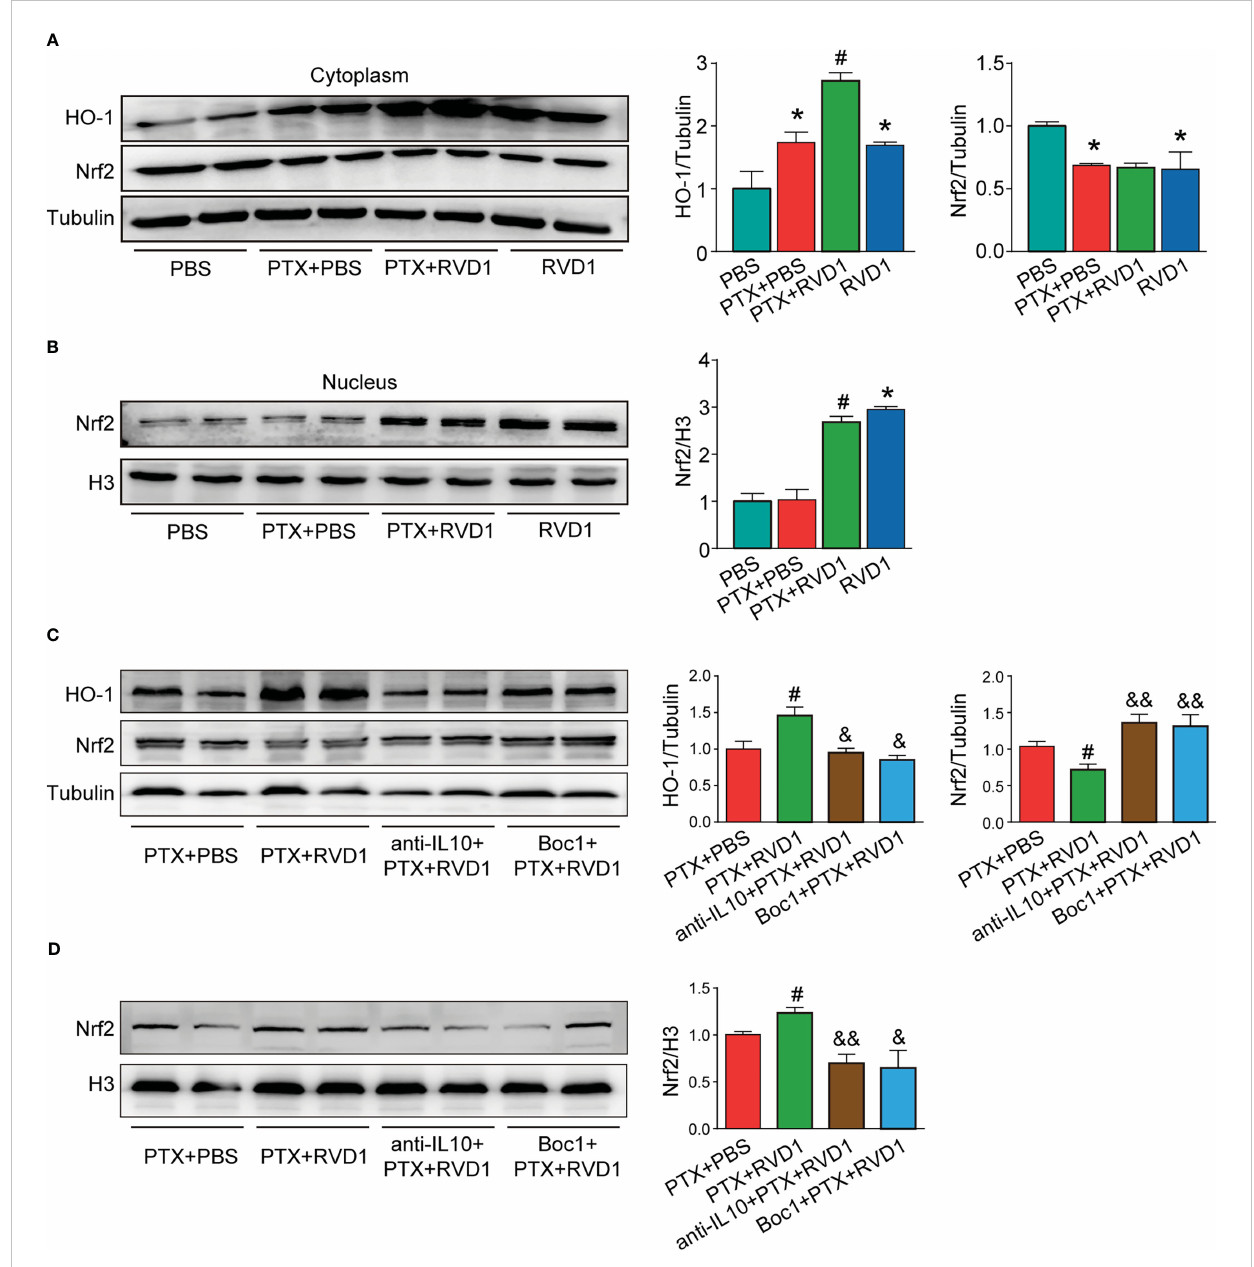
FIGURE 9 The BMDMs RvD1-FPR2-IL-10 axis plays a critical role in DRG neuronal antioxidant damage. BMDMs were treated with BOC1 (1 m M) for 3 h, then treated with RvD1 (250 nM) for another 3 h, and then treated with PTX (1 m M) for 24 h, then the condition medium was collected. The primary DRG neurons were treated with IL-10 neutralizing antibody, then stimulated with the above condition medium for 24 h. The cytoplasmic and nuclear protein was isolated, and the expression of Nrf2 and HO-1 was detected by Western blot, the band gray was analyzed using Image J (A – D) . *P<0.05 vs CON group; #p<0.05 vs PTX group; &p<0.05, &&p<0.01 vs PTX+RvD1 group. n=4. RvD1, resolvin D1; PTX,